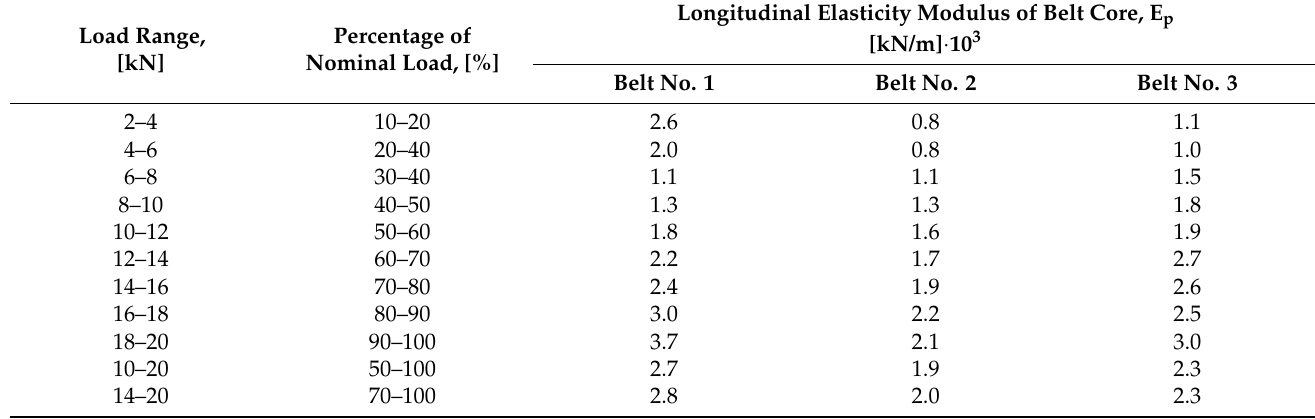
Table 6. Values of longitudinal elasticity moduli for the belt cores in various load